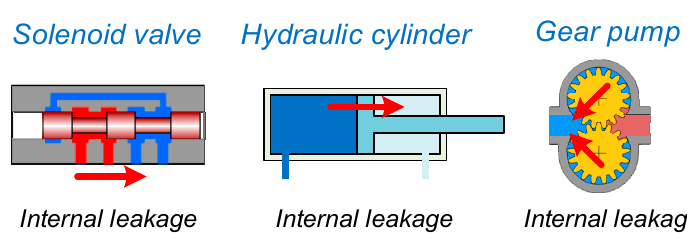
Figure 7. Leakage loss schematic diagram of the HTD.